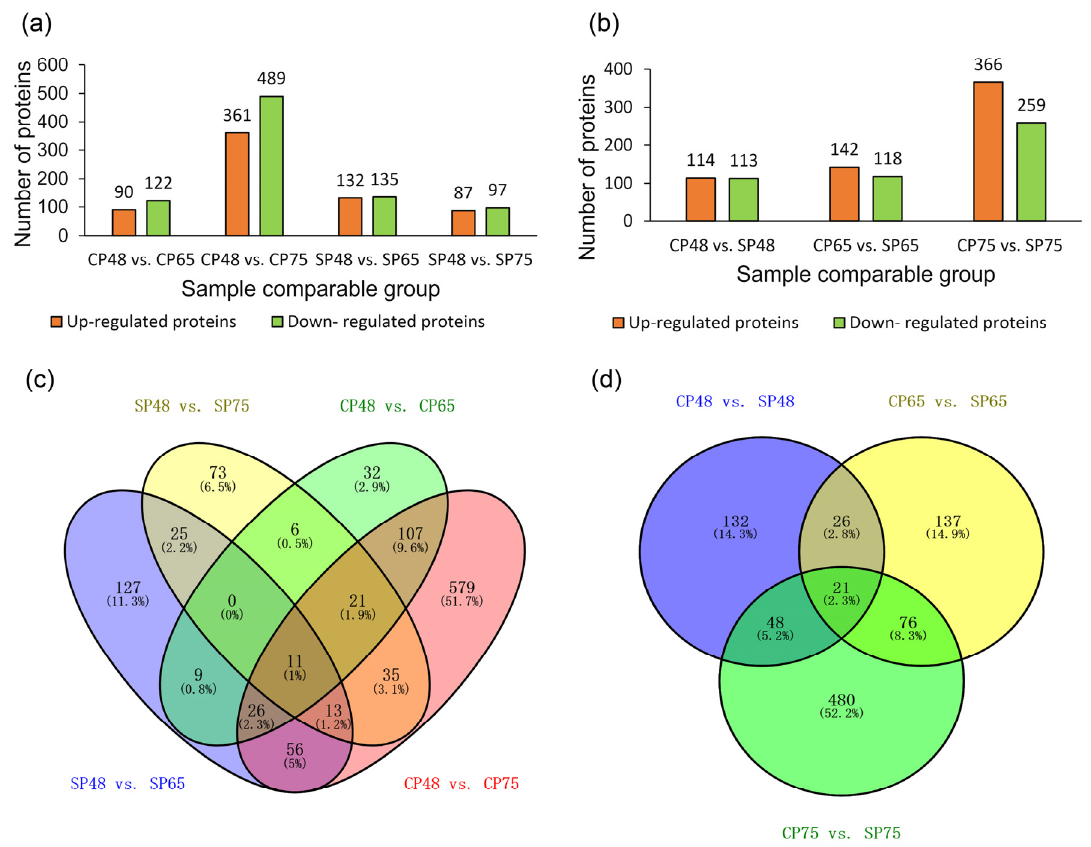
Figure 2. Differentially abundant proteins (DAPs) in all compared groups: ( a ) The information about DAPs was present in the compared groups of CP48 vs. CP65, CP48 vs. CP75, SP48 vs. SP65, and SP48 vs. CP75. ( b ) The information about DAPs was present in the compared groups of SP48 vs. CP48, SP65 vs. CP65, and SP75 vs. CP75. ( c ) DAPs were analyzed by the Venn diagram in the compared groups of CP48 vs. CP65, CP48 vs. CP75, SP48 vs. SP65, and SP48 vs. CP75. ( d ) DAPs were analyzed by the Venn diagram in the compared groups of SP48 vs. CP48, SP65 vs. CP65, and SP75 vs. CP75. CP48 represents 48 hours after cross-pollination, CP65 represents 65 hours after cross-pollination, CP75 represents 75 hours after cross-pollination, SP48 represents 48 hours after self-pollination, SP65 represents 65 hours after self-pollination, and SP75 represents 75 hours after self-pollination.